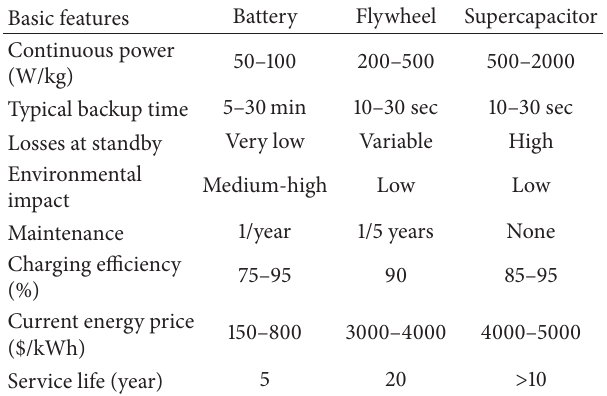
Table 2: Basic features of suitable storage devices in 𝜇 G system